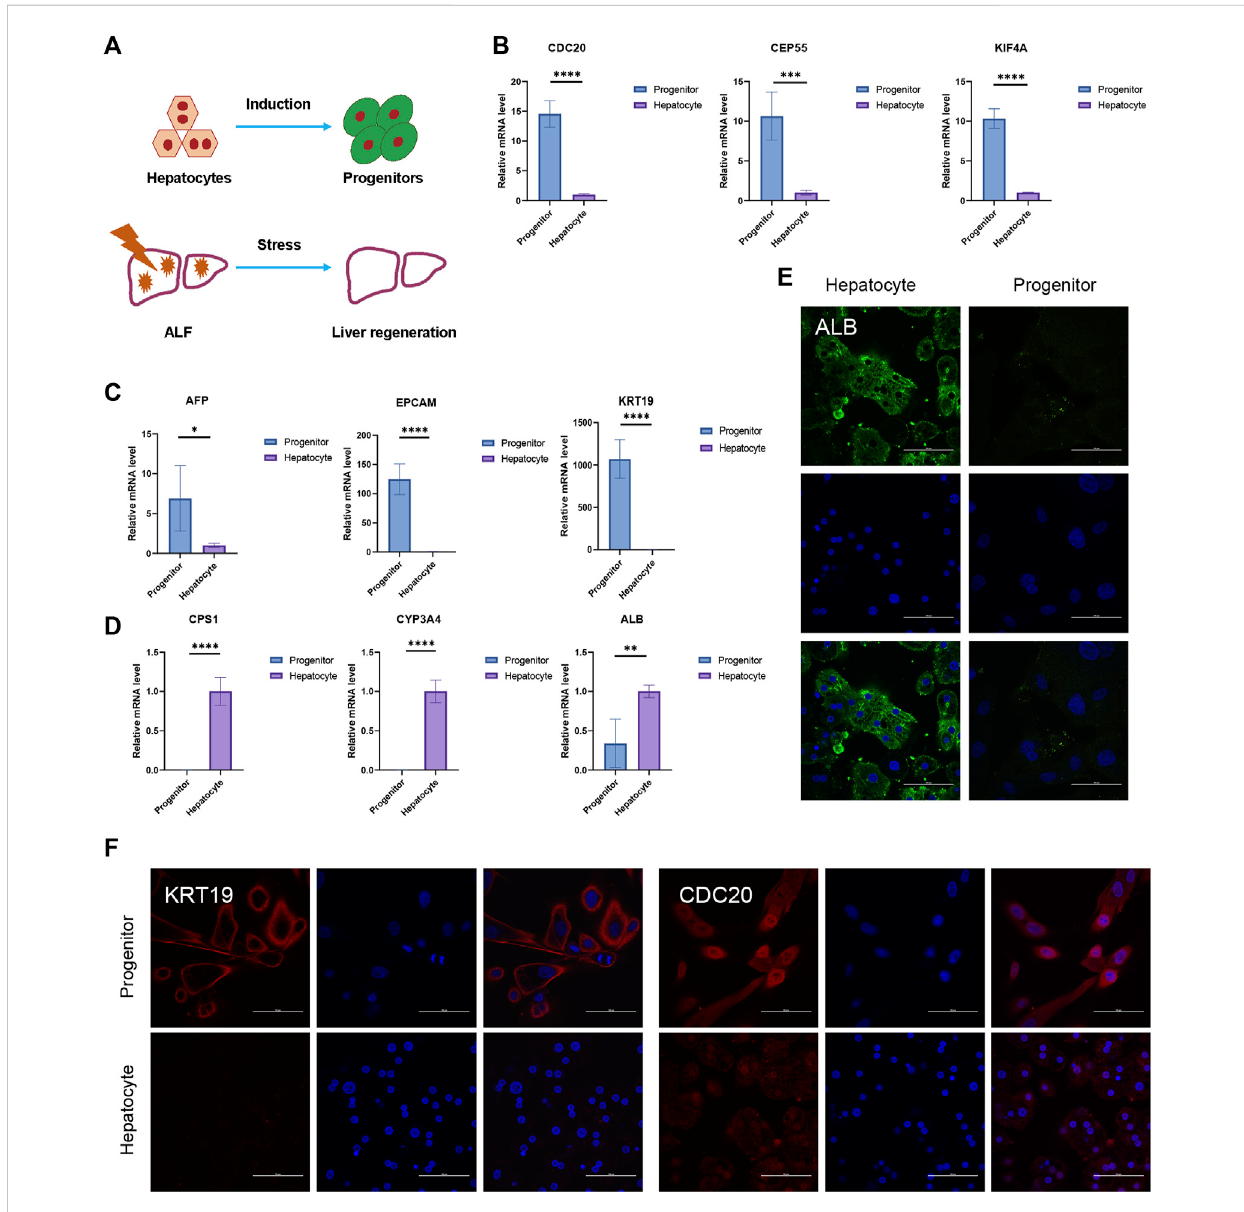
FIGURE 6 In vitro liver regeneration under physiological state. (A) Damage and regeneration pattern diagram. The process of hepatocytes turning into progenitors represents in vitro regeneration model. Liver regeneration occurs during ALF and represents in vivo regeneration model. (B – D) The relative expression of hub genes (B) , progenitor genes (C) , and liver functional genes (D) between hepatocytes and progenitors. N = 4. Data were statistically analyzed using Student ’ s t -test, and values were presented as mean ± SD. *indicates signi fi cant difference at p < 0.05, ** indicates signi fi cant difference at p < 0.01, *** indicates signi fi cant difference at p < 0.001, **** indicates signi fi cant difference at p < 0.0001. (E – F) Representative immuno fl uorescence staining images of ALB (E) , KRT19, and CDC20 (F) (Scale bars = 100